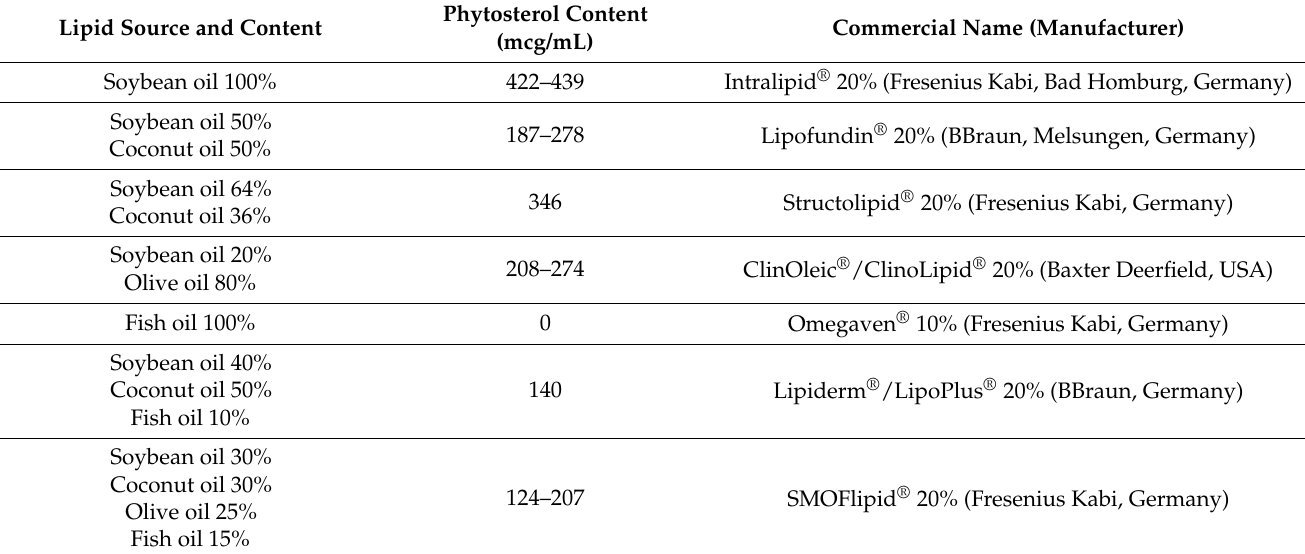
Table 3. Characteristics of IVFEs for PN